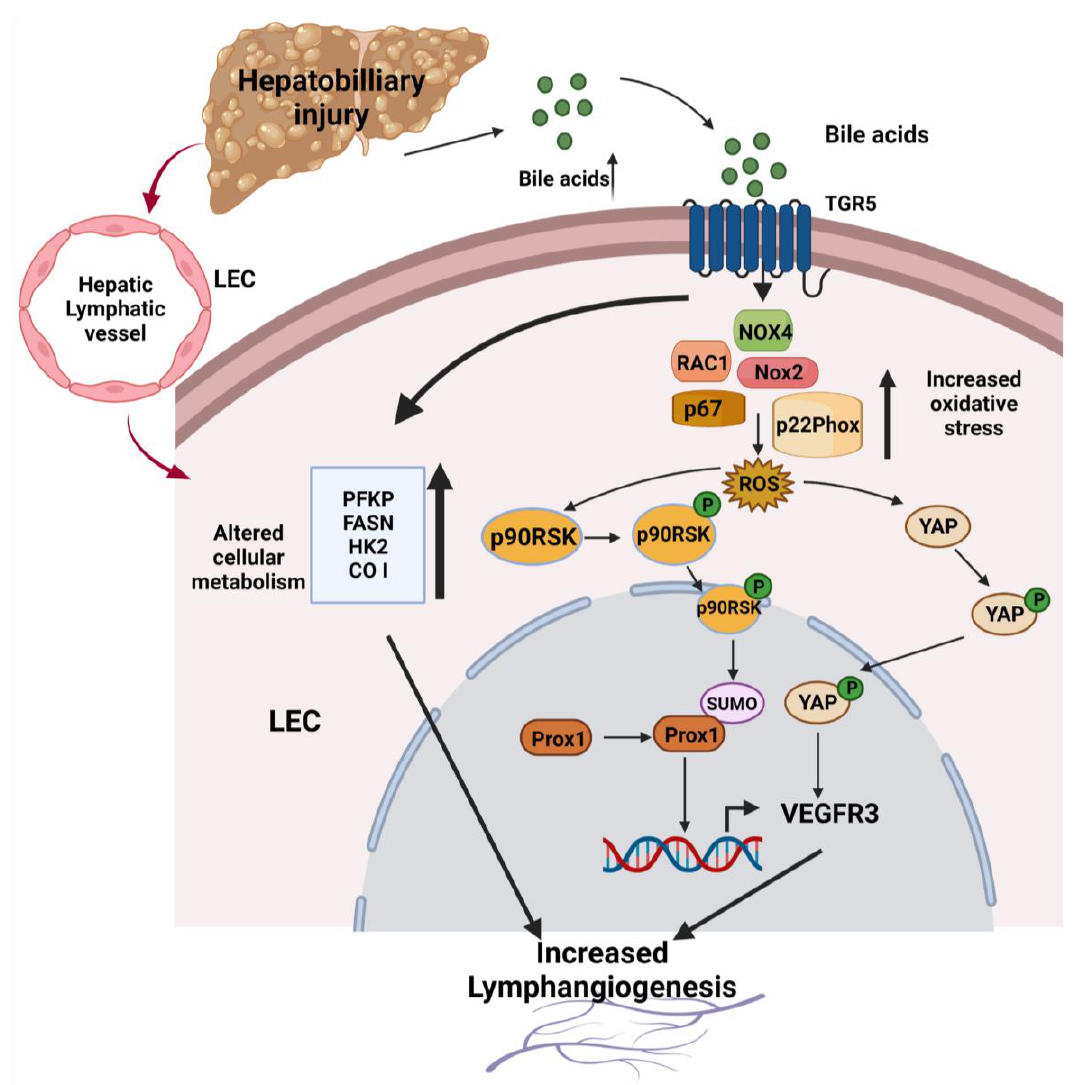
Figure 7. Schematic showing increased conjugated BAs induce pathological lymphangiogenesis through an ROS-p90RSK-YAP-VEGFR3-dependent mechanism. Conjugated BAs bind to TGR5 ex- pressed by the LECs and activate several key members of the redox or oxidative stress pathway. The activation of the redox pathway in turn produces ROS and activates the p90RSK via its phos- phorylation at S380. Activated pp90RSK induced the SUMOylation of Prox1, and SUMOylated Prox1 increased the transcription of VEGFR3, ultimately increasing lymphangiogenesis. Conjugated BA-induced ROS also activated the YAP, which in turn increased the lymphangiogenesis. BA also enhanced the cellular metabolism by increasing the mRNA expression of the metabolic genes, namely PFKP, HK2, CO I , and FASN , that play roles in enhancing lymphangiogenesis. Generated with BioRender.com (Toronto, ON, Canada).